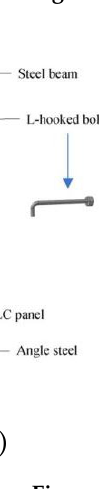
Figure 4. Connection types between ALC panel and steel beams (unit: mm). ( a ) The L-hooked bolt connector. ( b ) The pendulous Z-plate connector.